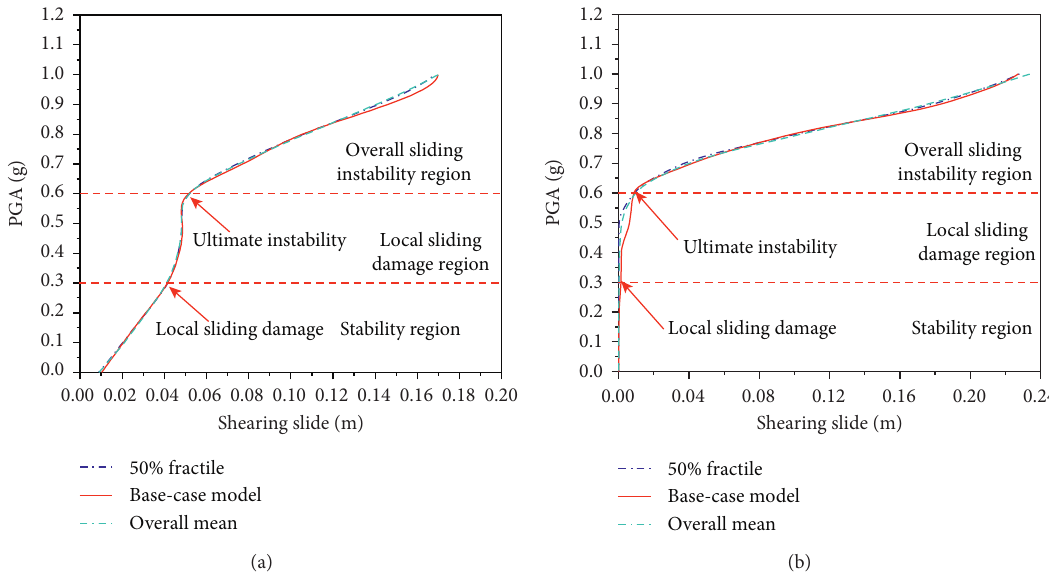
Figure 6: Median along with the base-case and overall mean shearing slides of (a) the starting point on the main sliding surface and (b) the ending point on the auxiliary sliding surface.